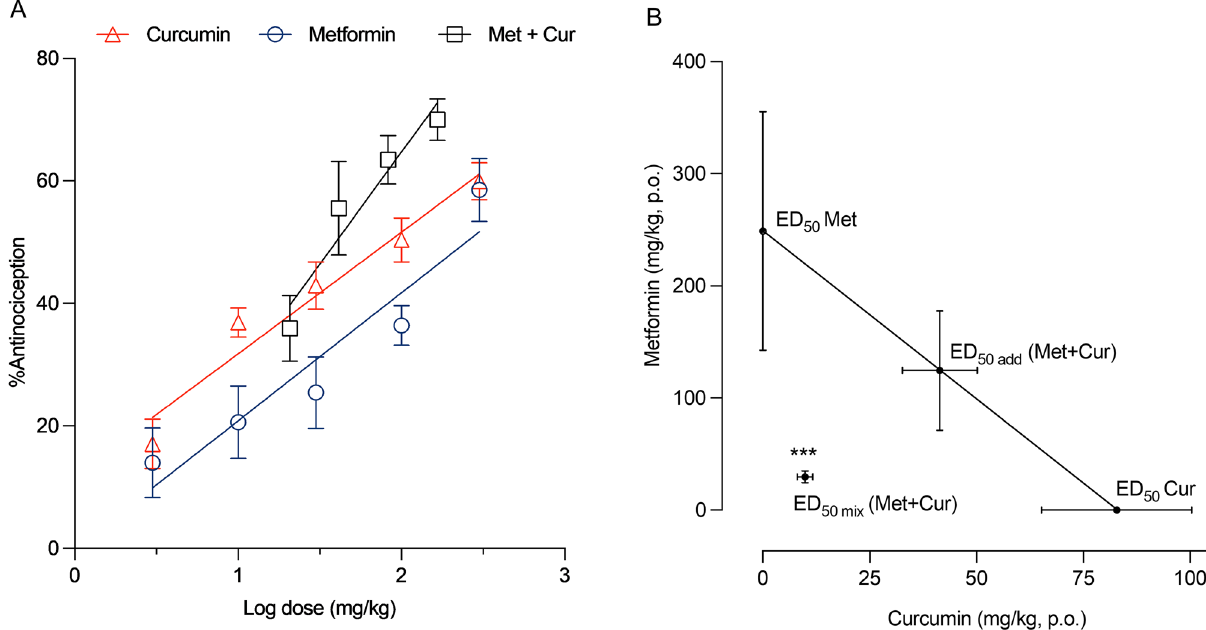
Figure 6. Isobolographic analysis of the antinociceptive interaction between curcumin and metformin in phase II of the formalin test. ( A ) Linear regression of log dose–response curves of curcumin, metformin, and curcumin-metformin combination. ( B ) The isobologram of the curcumin-metformin interaction at the fixed- dose ratio of 1:1. The straight line connecting the ED 50 s of curcumin and metformin represents the additive line. The horizontal and vertical bars represent the SEM. ED 50 (Cur) and ED 50 (Met) correspond to the ED 50 s obtained with individual treatment of curcumin and metformin, respectively. ED 50 add and ED 50 mix correspond to the theoretical and experimentally derived ED 50 s of curcumin and metformin combination. The ED 50 mix value lies far below the additive line, suggesting significant synergism. *** p < 0.001 compared to the ED 50 add, by student’s t